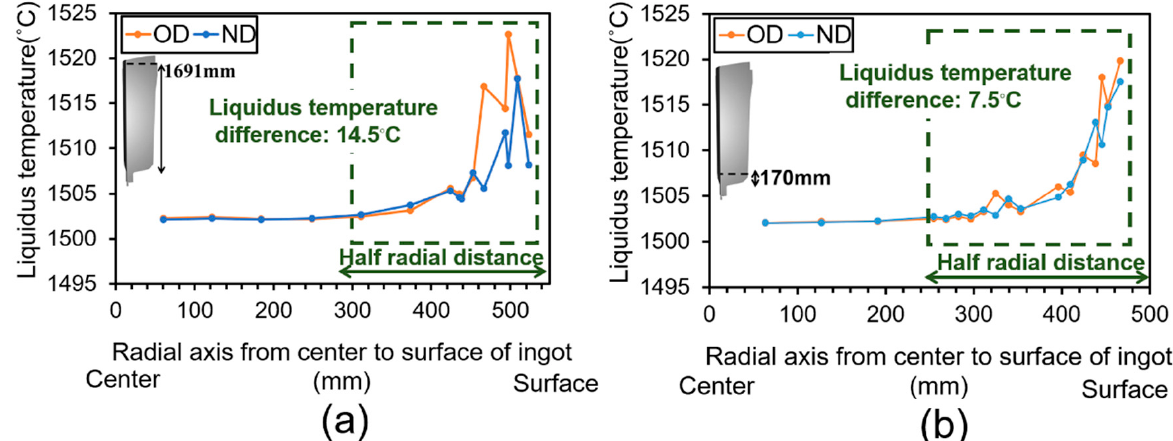
Figure 13. Liquidus temperature °C in OD and ND at ( a ) In the radial direction, a height of 1691 mm from the bottom at the hot top area, ( b ) In the radial direction, a height of 170 mm from the bottom at the ingot body area.